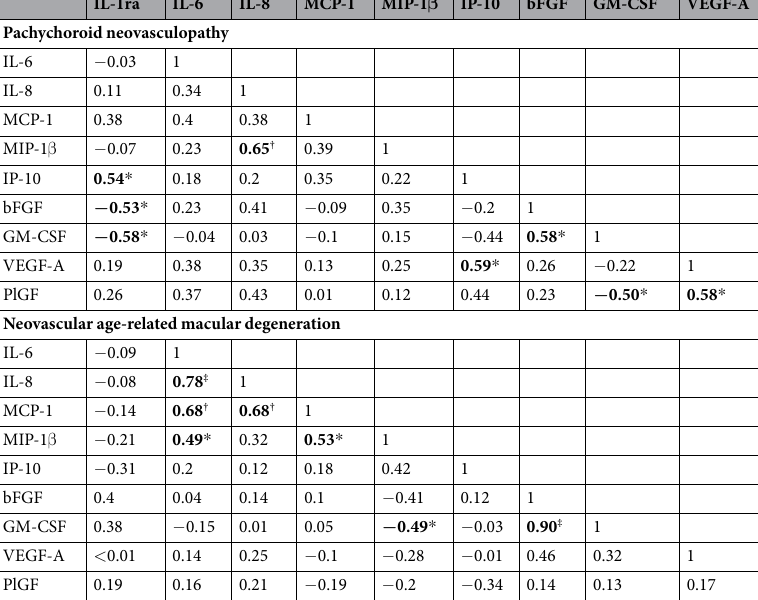
p = 0.04). In the nAMD group, there were positive correlations between bFGF and GM-CSF (r = 0.90, p < 0.001), IL-6 and IL-8 ( r = 0.78, p < 0.001), IL-6 and MCP-1 ( r = 0.68, p = 0.002), IL-8 and MCP-1 ( r = 0.68, p = 0.002),